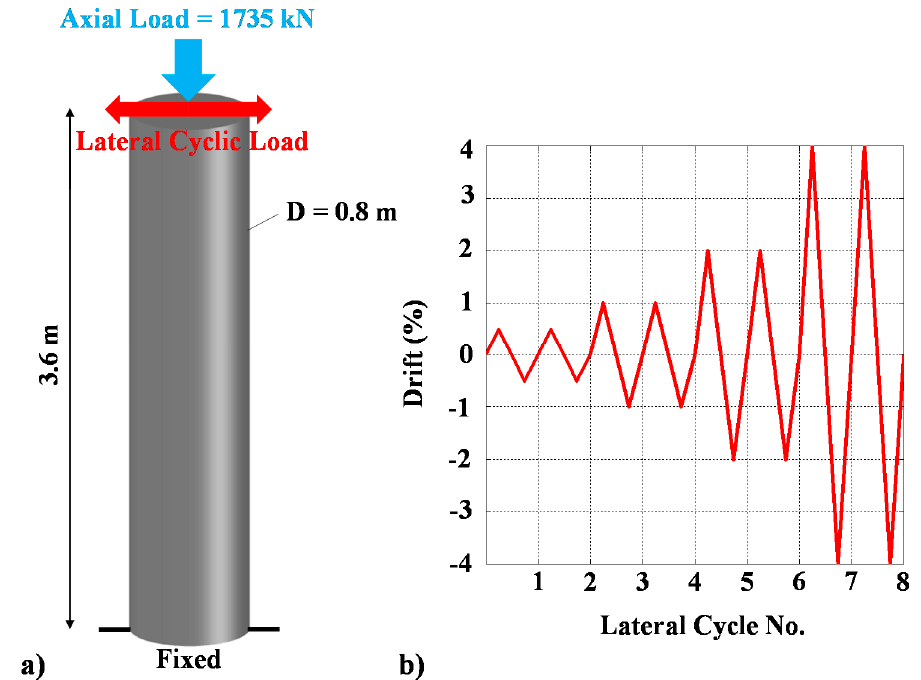
Figure 5. ( a ) Loading and boundary conditions; ( b ) lateral loading protocol.